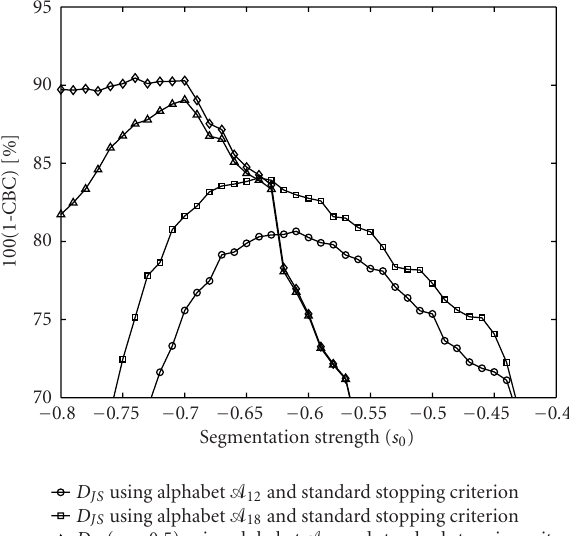
Figure 12: Accuracies of recursive segmentation for di ff erent thresholds of segmentation strength using Jensen-Shannon and Jensen-R´enyi divergences with (cid:1) 12 and (cid:1) 18 alphabets and two stop- ping criterions for the genome of bacterium Rickettsia prowazekii